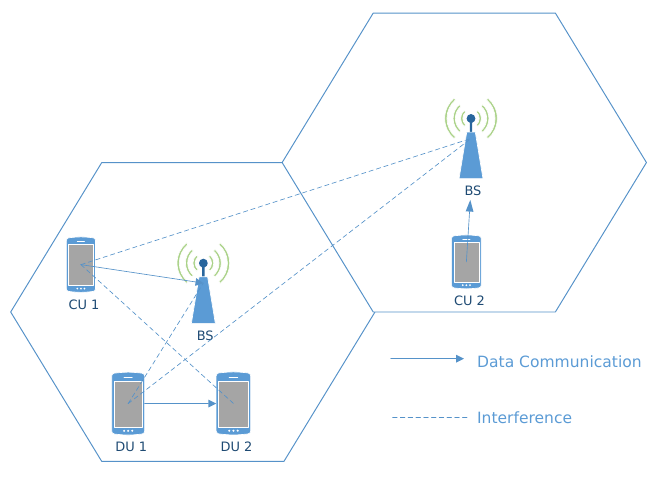
Figure 1. System